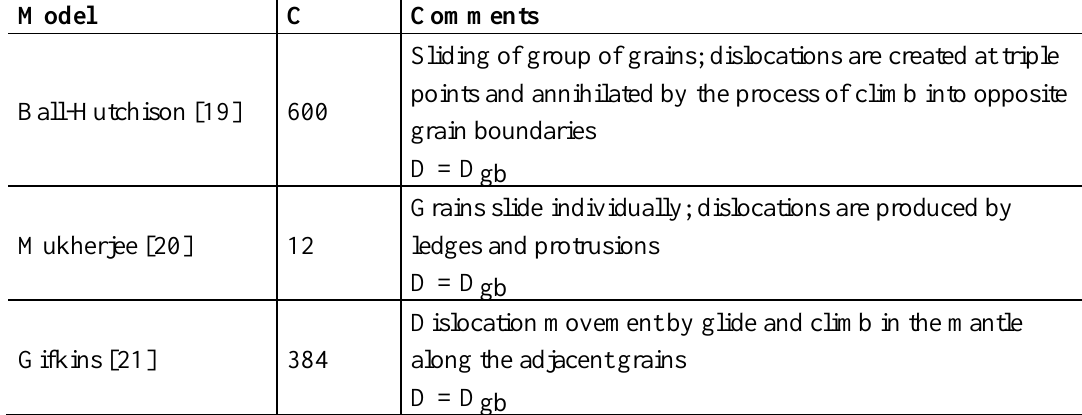
Table 1. Proposed deformation mechanisms for the superplastic region (Region